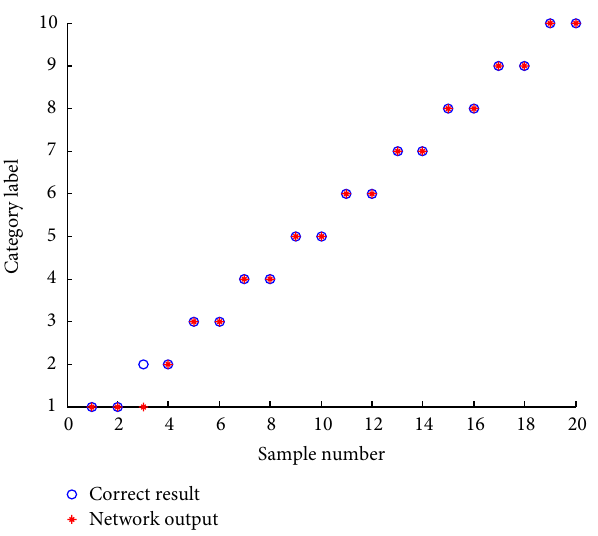
Figure 4: Detection results of PSO–SOM mode.